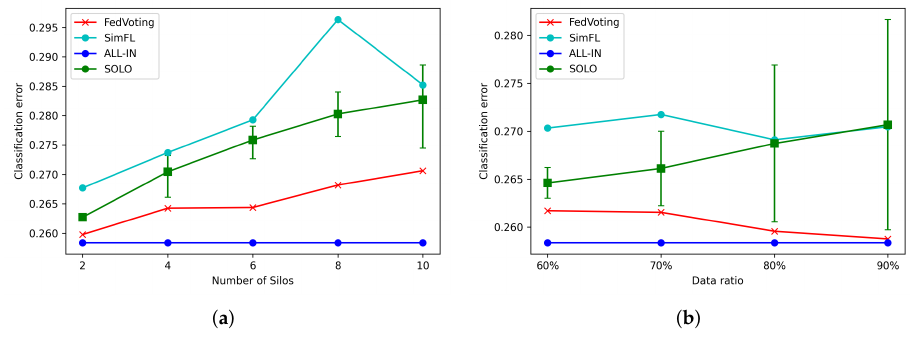
Figure 7. The prediction results of Disneyland visit in different conditions. ( a ) Classification errors of different numbers of silos. ( b ) Classification errors of different ratios of data